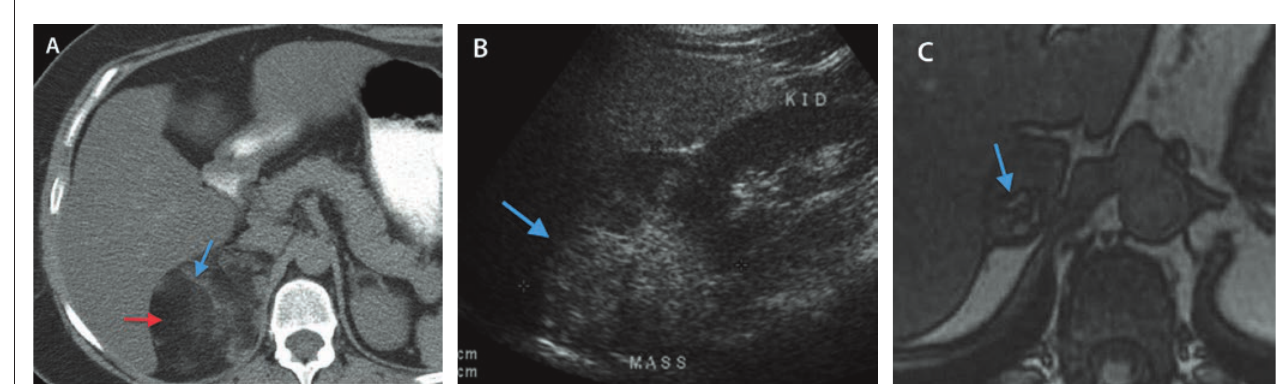
Fig. 11. Myelolipoma. (A) Axial unenhanced CT scan image showing a well-defined right adrenal mass with macroscopic fat (red arrow). The myeloid elements have a higher soft-tissue density (blue arrow). (B) Longitudinal ultrasound image demonstrating a heterogeneous predominantly echogenic adrenal mass abutting the superior pole of the right kidney (blue arrow). (C) Axial opposed phase MRI image demonstrating India-ink artifact (blue arrow).